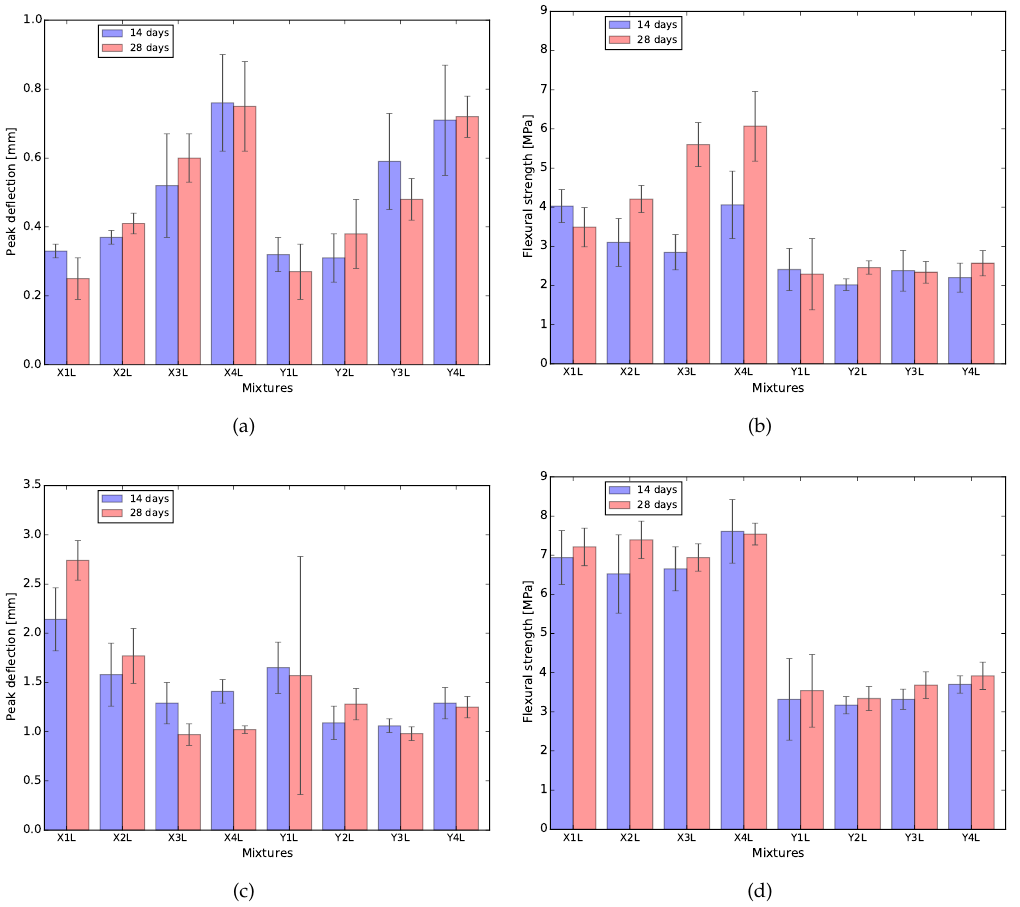
Figure 6. Summary of the flexural test for XVA3PVA20 (shortned to X) and YVA4PVA20-S05 (shortned to Y) samples. ( a ) deflection at first crack; ( b ) flexural strength at first crack; ( c ) deflection at maximum flexural strength; ( d ) maximum flexural